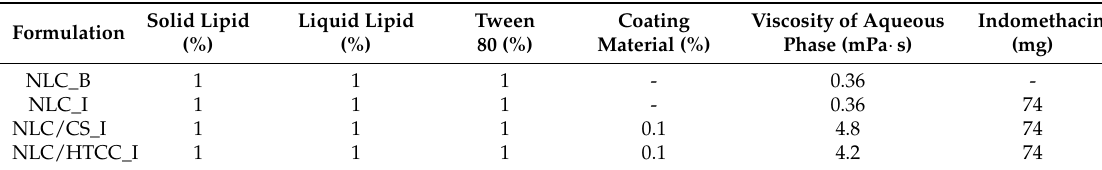
Table 1. Compositions to prepare indomethacin loaded NLC